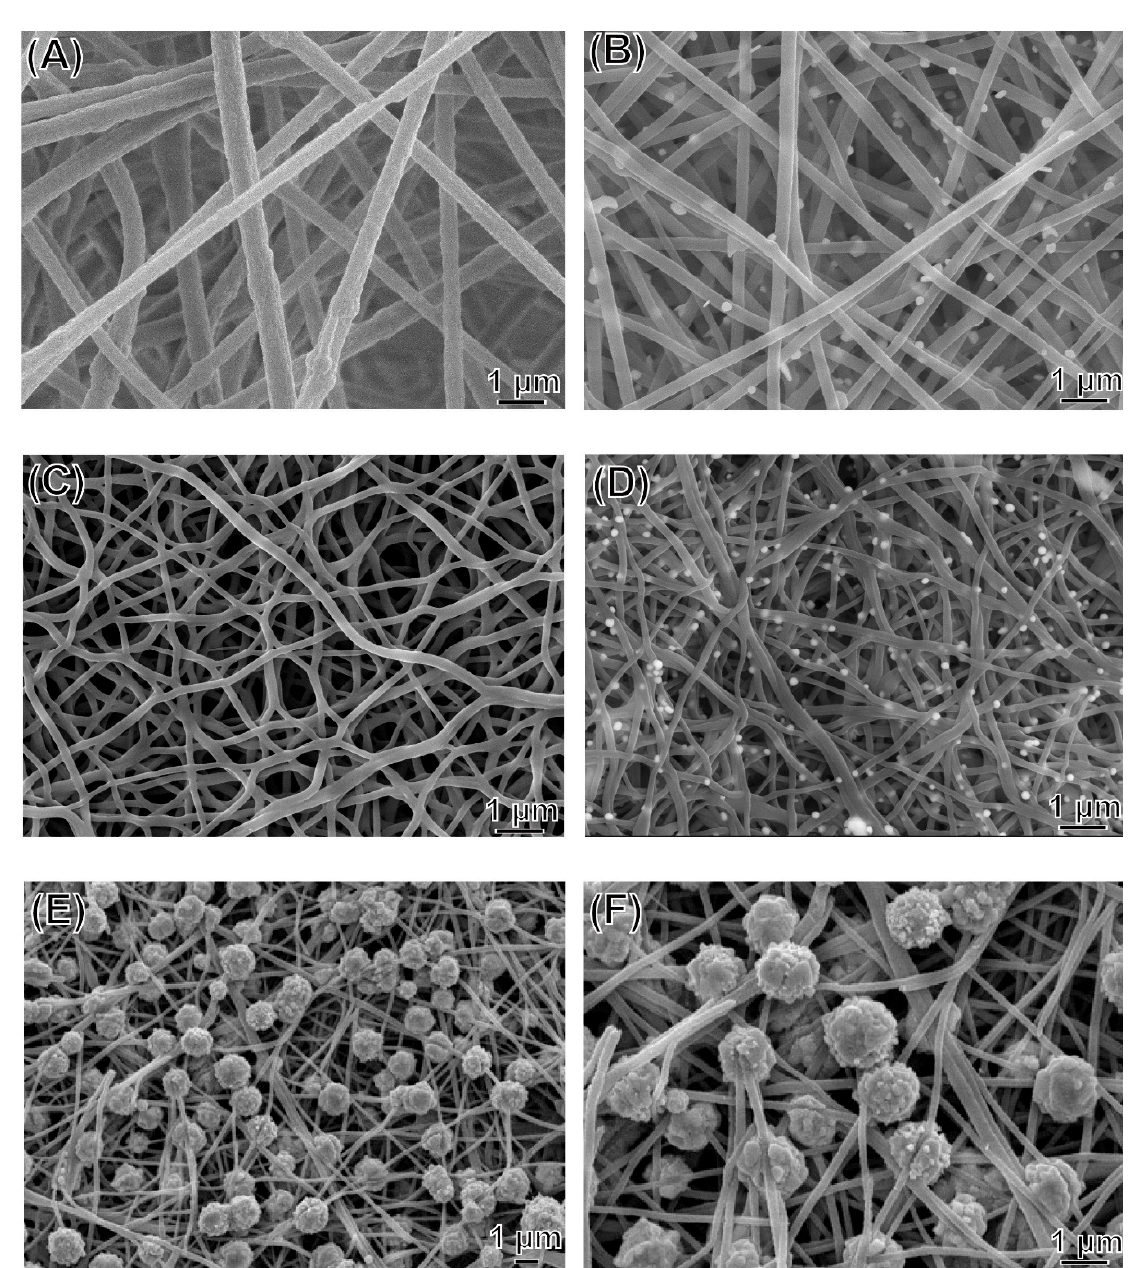
Figure 1. FE-SEM images of ( A ) pure polyacrylonitrile (PAN) nonwoven mats; ( B ) Ag/PAN nonwoven mats; ( C ) calcined pure PAN nonwoven mats; ( D ) calcined Ag/PAN nonwoven mats; ( E , F ) urchin-like Ag–Au/PAN nonwoven mats.